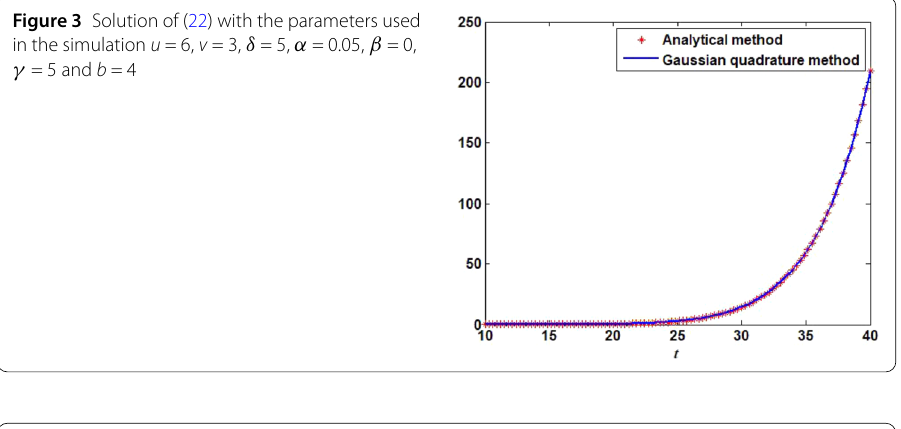
Figure 4 Solution of (23) with the parameters used in the simulation u = 6, v = 3, δ = 5, α = 0.5, β = 0, γ = 5 and b = –6